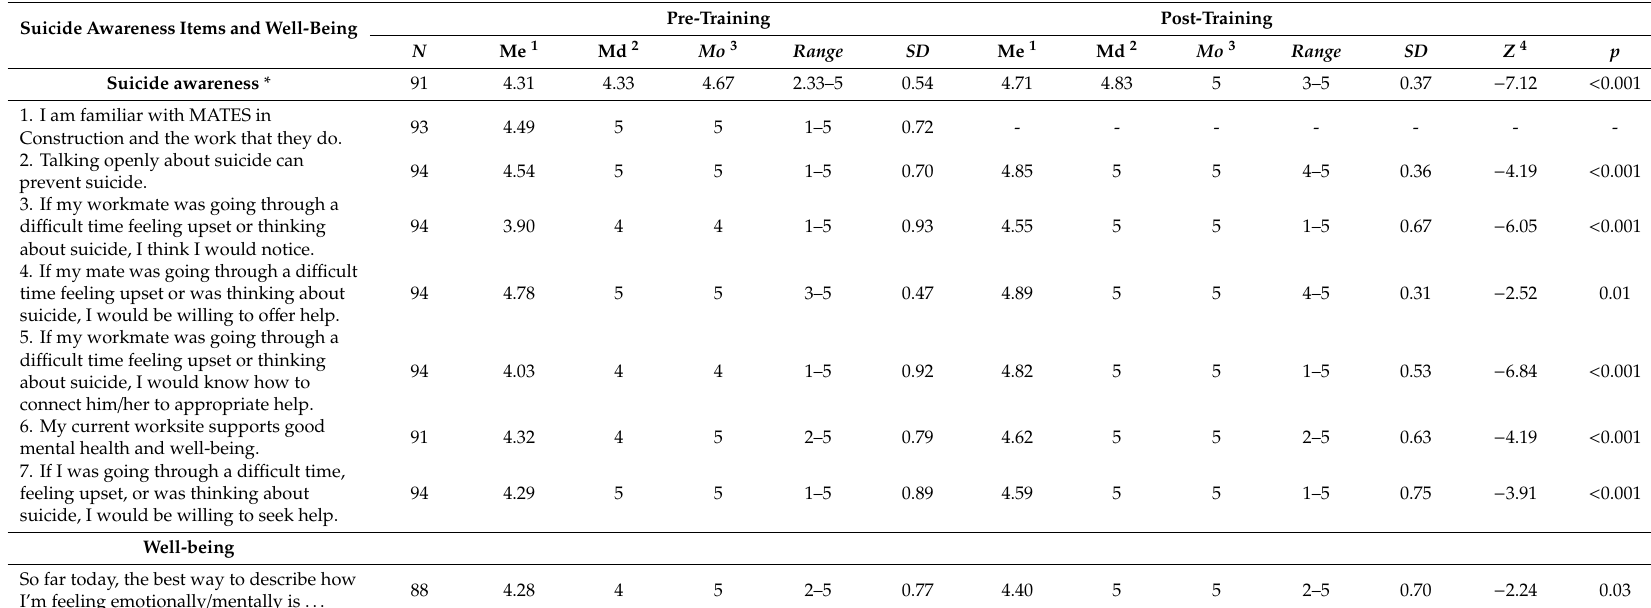
Table 1. Suicide awareness: pre- and post-connectors’